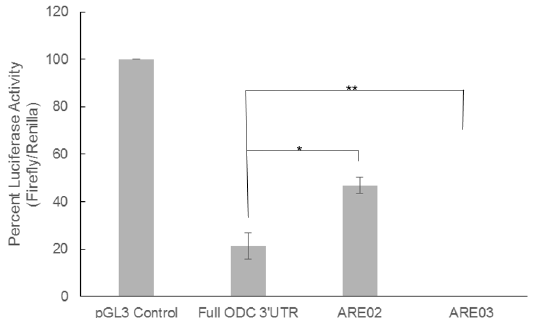
Figure 3. The ODC 3 ′ UTR contains a negative regulatory element between bases 1969 and 2141. The full length ODC 3 ′ UTR as well as two distal end truncations of the ODC 3 ′ UTR were inserted into the pGL3 control vector in order to show the influence of the 3 ′ UTR of ODC on luciferase activity. C5N cells were transfected with either the pGL3 control vector, pODC3 ′ UTRLuc (Full ODC 3 ′ UTR), ARE02 or ARE03. A plasmid containing the renilla luciferase gene was co-transfected into these cells and used as a transfection efficiency control. Luciferase activity was measured 48 h after transfection. Firefly luciferase activity was normalized to renilla luciferase for each sample. The luciferase activity of pGL3 control was set to 100% and the samples from cells transfected with pODC3 ′ UTRLuc (Full ODC 3 ′ UTR), ARE02 and ARE03 are shown as a percentage of the pGL3 control luciferase activity. Values are means ± S.E. ( n = 6). Differences in luciferase activity between pGL3 control and Full ODC 3 ′ UTR, ARE02 and ARE03 were all statistically significant. Statistics were performed to compare the luciferase activity between Full ODC 3 ′ UTR, ARE02, and ARE03. * p < 0.05 and ** p < 0.005.